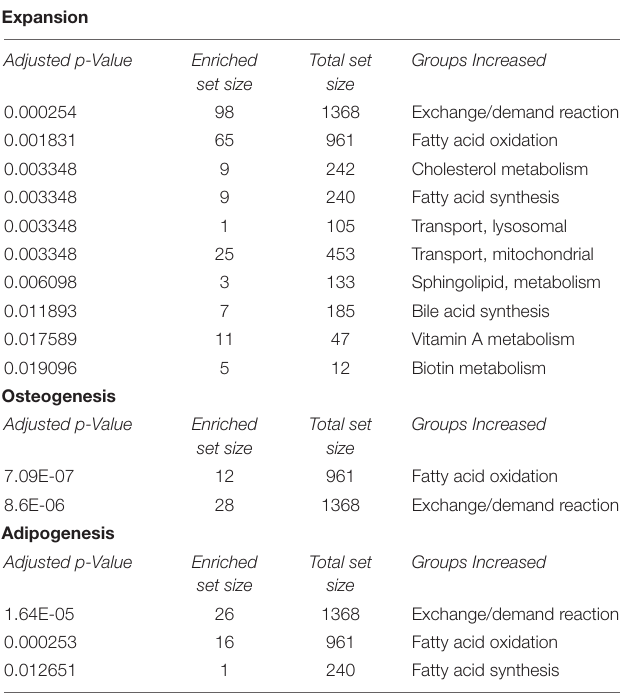
TABLE 3 | Showing subsystems that have a significantly overrepresented (adjusted p -value < 0.05) number of more active reactions in the relevant model compared to the other differentiation lineage in the case of osteogenesis/adipogenesis or compared to the two differentiation models in the case of